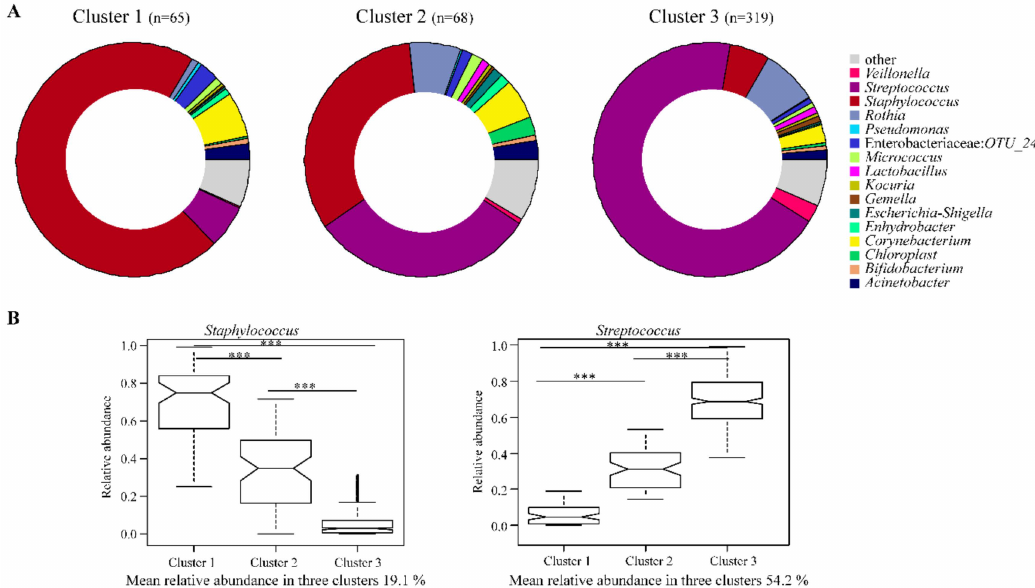
Figure 2. Human breast milk (HBM) bacterial profiles of the three clusters in which samples were grouped at genus level. ( A ) Pie charts show the mean relative abundances in each cluster at the genus level (for genera with abundance > 0.05%). ( B ) Notched box plots show the mean relative abundance of the predominant bacteria genera in each cluster. The notched box signifies the 75% (upper) and 25% (lower) quartile, showing the distribution of 50% of the samples. The median is represented by the line inside the box plot, and the notch shows the 95% confidence interval for the median. The whiskers (top and bottom) represent the maximum and minimum values. Outliers, which are beyond 1.5 times the interquartile range above the maximum value and below the minimum value, are shown with open circles. ( ∗∗∗ p < 0.001).